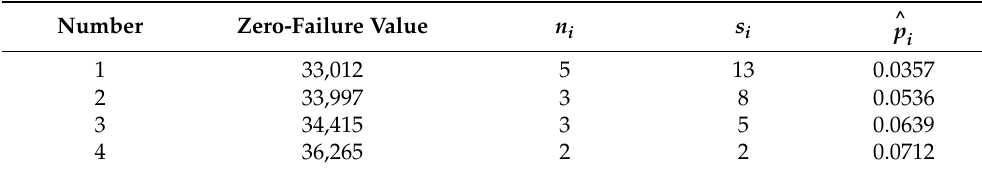
Table 5. Zero-failure